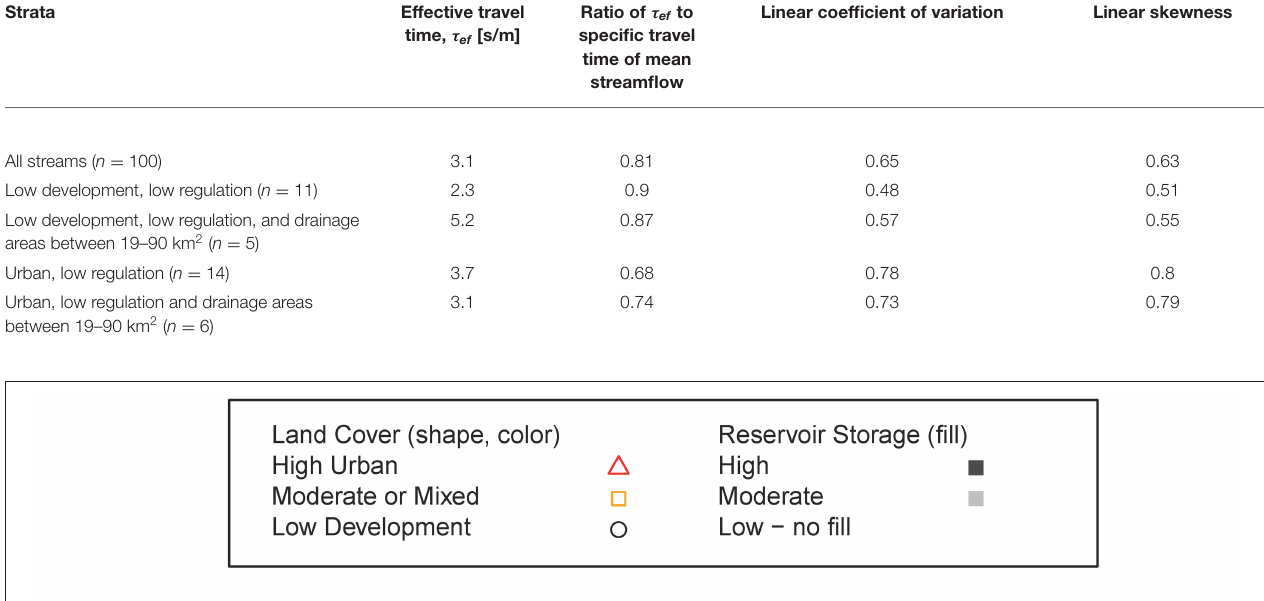
TABLE 2 | Cross-site median values of travel time and instantaneous streamflow distribution statistics for five strata of streams. Strata